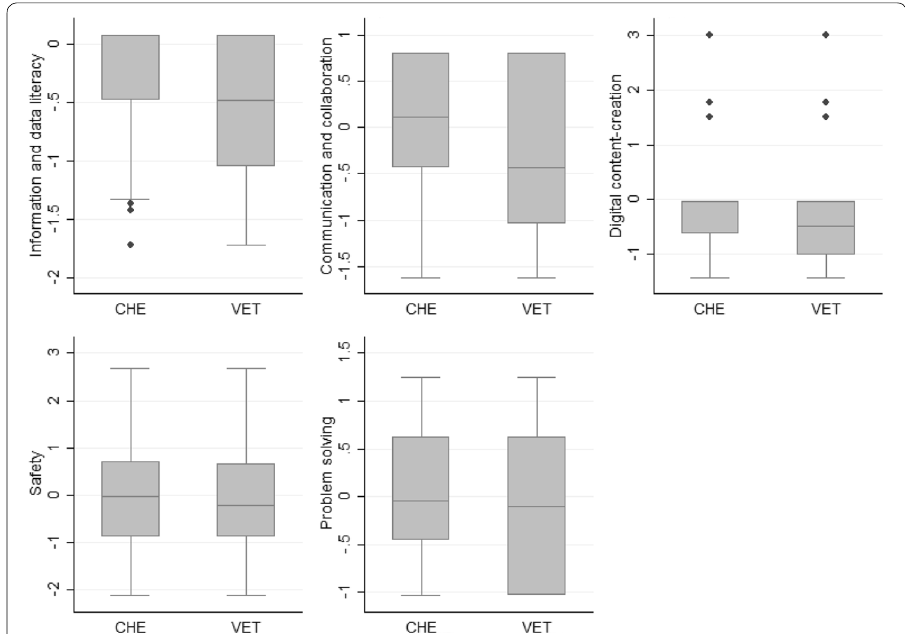
Fig. 1 Digital competences of cooperative student concept by CHE Cooperative higher education and VET Vocational education and training (standardized Score of